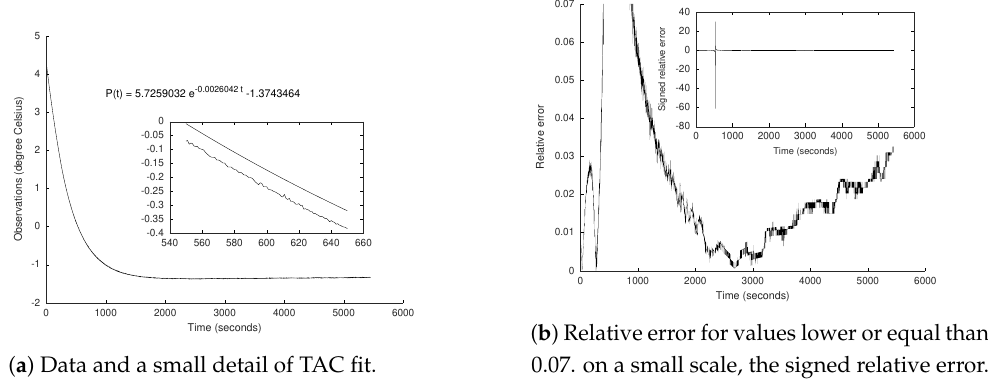
Figure 2. Some graphical aspects of this TAC implementation. In the numerical analysis bibliography, relative error is defined with or without sign; in this paper, we will consider the latter. A spike can be seen in the small window of ( b ). This spike should not be considered as an indicator of a poor adjustment of the curve to the data. On the contrary: the spike is due to the proximity of the data to zero; however, the error remains bounded. This is because curve and data are close enough to control the fact that we are virtually dividing by zero.